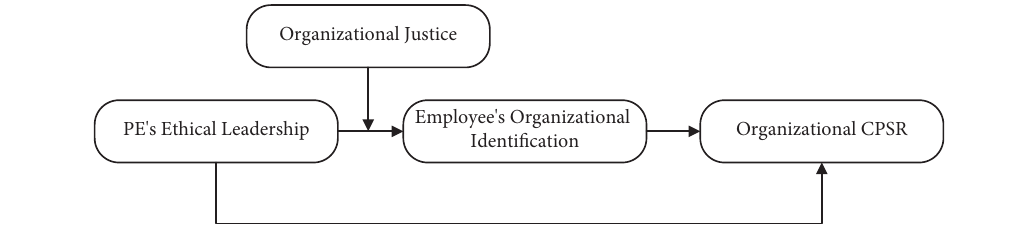
Figure 1: Conceptual model of organizational Table 1: Demographics of surveyed respondents.